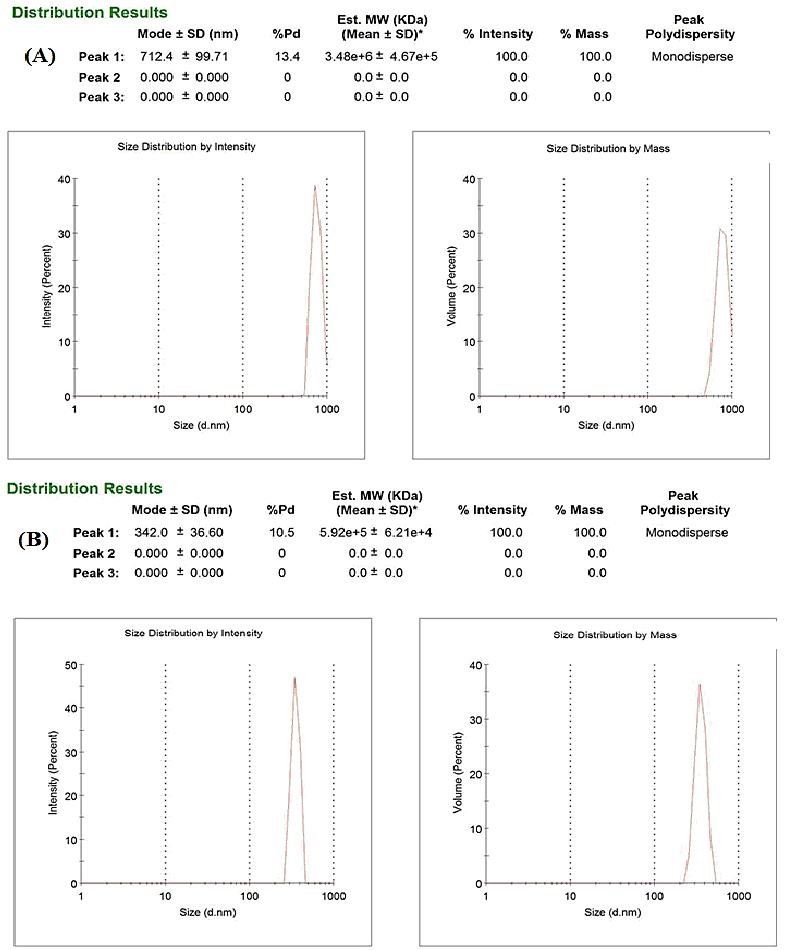
Figure 3. Globule size distribution after ( A ) homogenization only and ( B ) homogenization followed by sonication.